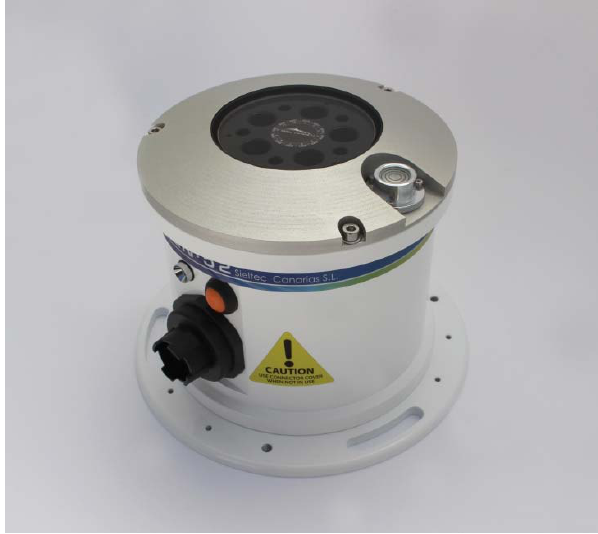
Figure 2. ZEN-R52 Figure 2. ZEN ‐ R52 picture.